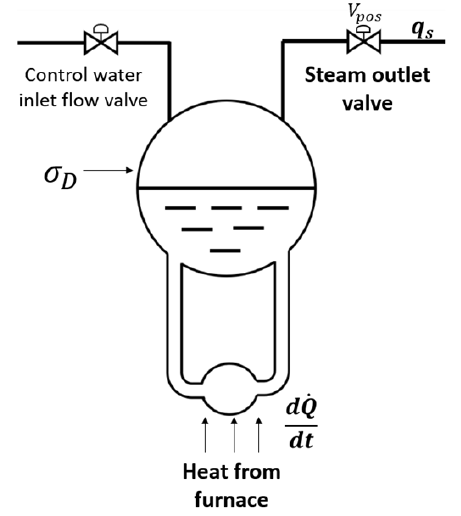
Figure 4. Schematic diagram of the drum